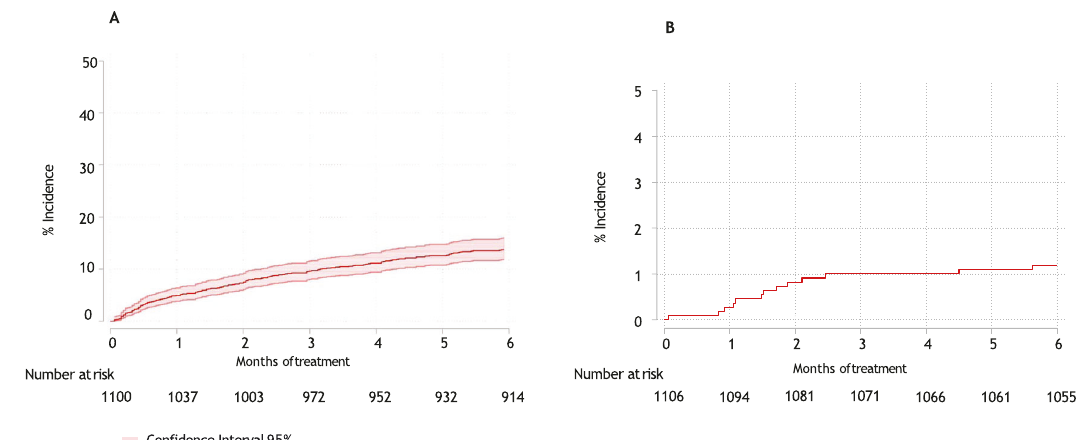
Fig. 3 Cumulative incidence. A Cumulative incidence of severe infection and B mortality by